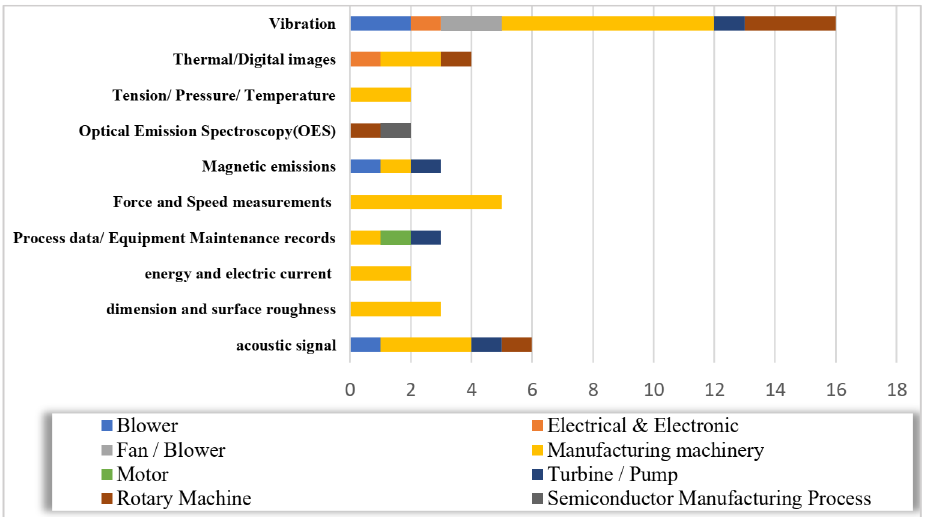
Figure 14. Comparison of investigated equipment and type of monitored